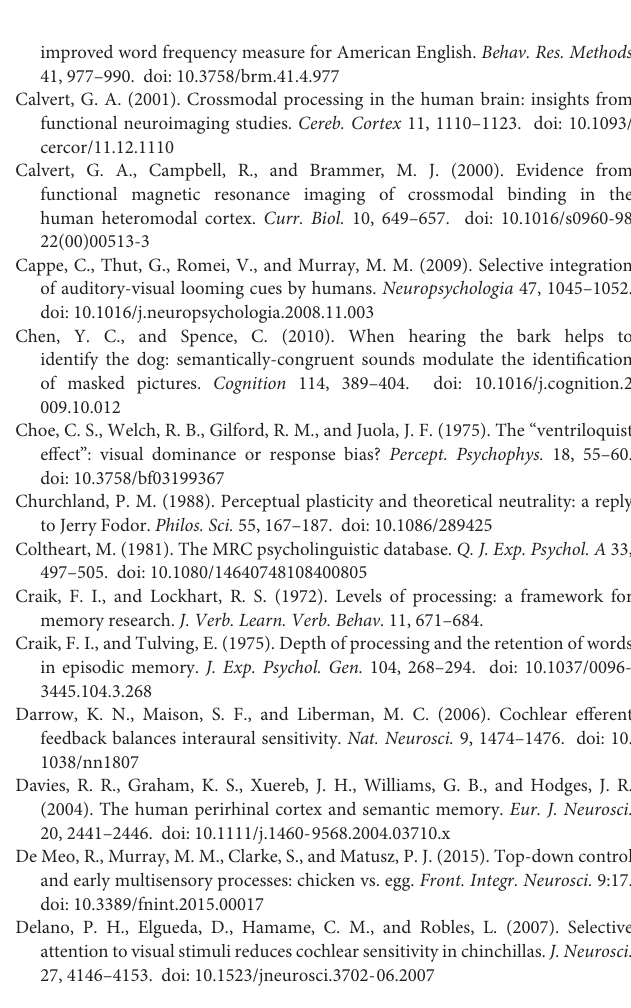
Supplementary Table 1 | Mean word frequency, concreteness, familiarity and imageability of word stimulus lists. Word frequency (zipf) was calculated based on SUBTLEXUS (Brysbaert and New, 2009), and concreteness, familiarity, and imageability ratings were taken from the MRC Psycholinguistic Database (Coltheart, 1981). Numbers in parentheses represent standard deviations. Supplementary Table 2 | Mean word frequency, concreteness, familiarity and imageability of labels in sound stimulus lists. Supplementary Table 3 | Comparison of word frequency, concreteness, familiarity, and imageability of labels in word and sound lists. Supplementary Table 4 | Number of items per semantic category in the spoken word and environmental sound blocks in the main and follow-up (matched) analyses. Items in the follow-up matched analyses were chosen by including all items from the block containing the fewest objects per category (e.g., “ear,” “finger,” “skeleton” from anatomy in the spoken word block) and selecting a corresponding object from the more populated block that most closely resembled each object in the less populated block (e.g., “nose,” “lips,” “heart,” respectively in the environmental sound